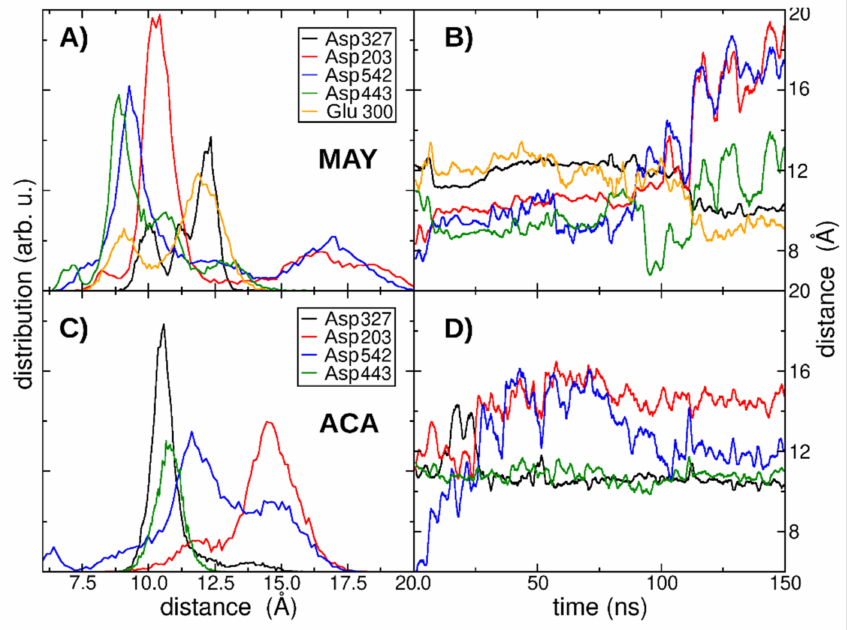
Figure 7. Distribution of residues-ligand distances in ( A ) MAY and ( C ) ACA and distance versus simulation time of ( B ) MAY and ( D )